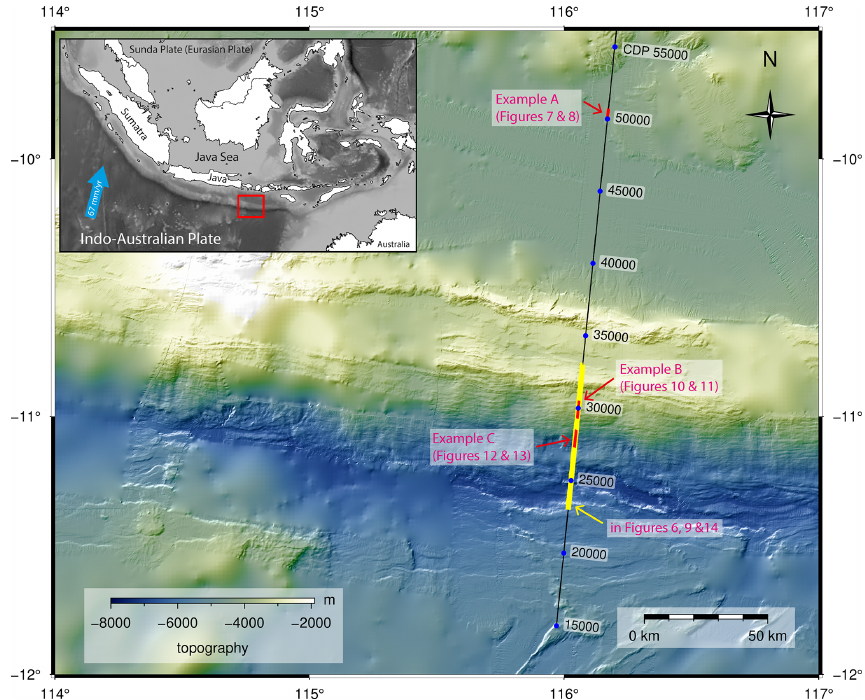
Figure 5. Map of the study area offshore southern Java, created by the authors using the open-source software Generic Mapping Tools (GMT). Local multi-beam bathymetry data were acquired during the SO190 cruise and overlain on the global GEBCO_2020 grid (GEBCO Bathymetric Compilation Group, 2020). The location of the multi-channel and collocated wide-angle seismic profile is shown by a black line. Three examples at locations A, B, and C (marked in red) of the NRM-based velocity update for the depth tomography and pre-stack depth migration result are discussed in detail. Example A is located at shallow depth with simple complexity, whereas examples B and C are crossing the subduction trench and accretionary wedge (yellow line) and show highly complex structures where standard velocity analyses mostly fail because of discontinuous highly dipping